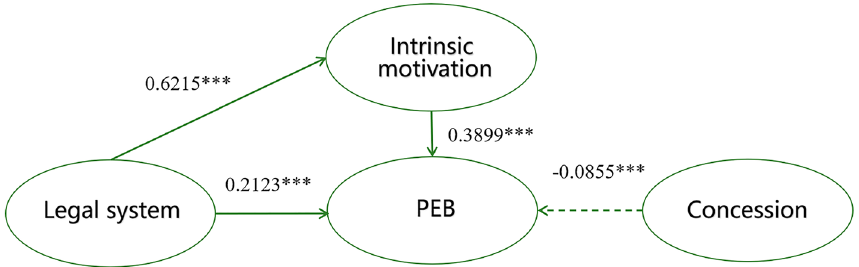
Figure 2. A relationship model of intrinsic motivation, legal system, concession and pro-environmental behavior.